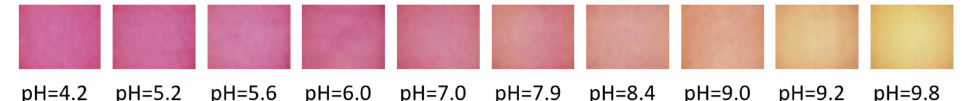
Figure 1. The calibration set of the pH indicator containing samples in the range pH 4–10. Acidic pa- pers were impregnated with the methyl-red solution and were alkalized by magnesium bicarbonate.